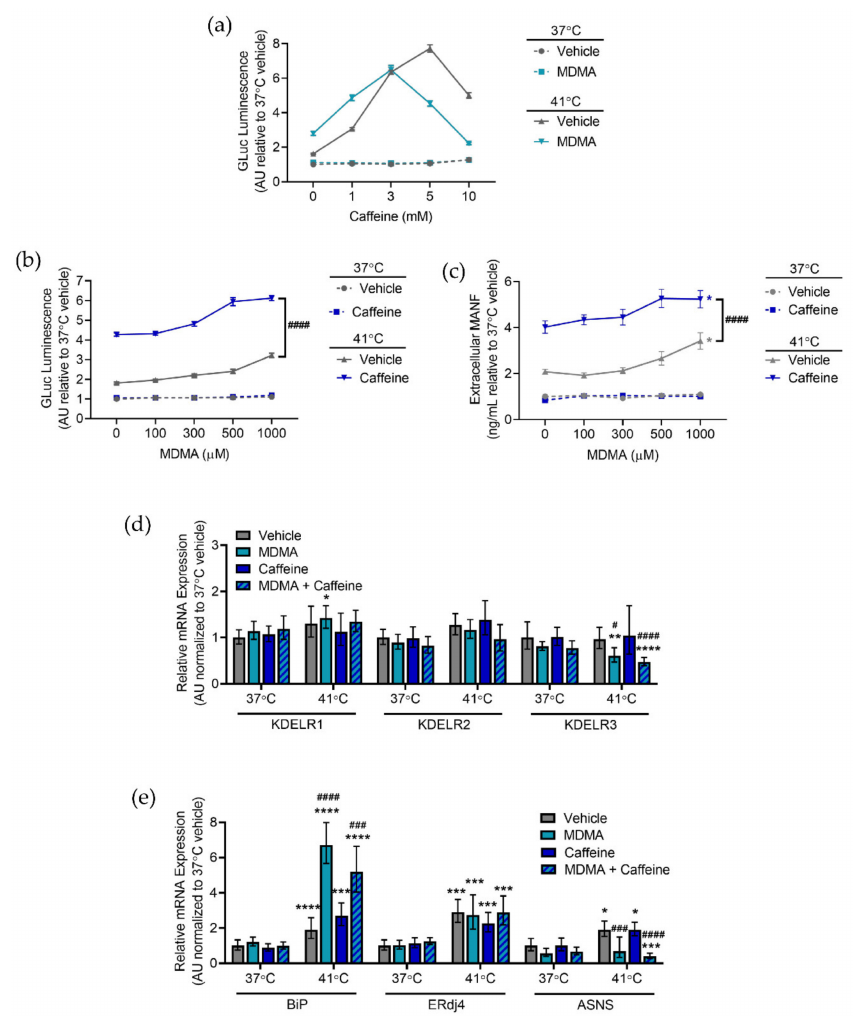
Figure 6. Caffeine and MDMA in combination affect hyperthermia-induced cellular responses. ( a ) GLuc (arbitrary units: AU) in the media from SH-SY5Y cells stably expressing GLuc-ASARTDL after treatment with vehicle or 500 µ M MDMA in combination with a dose response of caffeine and incubation at 37 ◦ C or 41 ◦ C for 24 h (mean ± SEM, n = 24). ( b ) GLuc (arbitrary units: AU) in the media from SH-SY5Y cells stably expressing GLuc-ASARTDL after treatment with vehicle or 1 mM caffeine in combination with a dose response of MDMA and incubation at 37 ◦ C or 41 ◦ C for 24 h (mean ± SEM, n = 24, three-way ANOVA with slice decomposition, #### p < 0.0001 vehicle vs. caffeine at 41 ◦ C). ( c ) MANF in media from SH-SY5Y cells treated with vehicle or 1 mM caffeine in combination with a dose response of MDMA and incubation at 37 ◦ C or 41 ◦ C for 24 h (mean ± SEM, n = 6, three-way ANOVA with slice decomposition, * p < 0.05 vehicle vs. MDMA at 41 ◦ C, #### p < 0.0001 vehicle vs. caffeine at 41 ◦ C. ( d ) KDELR1 , KDELR2 , and KDELR3 mRNA levels analyzed with real-time RT-qPCR after treatment with vehicle, 1 mM MDMA, 1 mM caffeine, or a combination of 1 mM MDMA and 1 mM caffeine and an 8 h exposure to 37 ◦ C or 41 ◦ C. Data are shown as relative mRNA expression (arbitrary units: AU) relative to control (2 − ddCq ± upper and lower limits, n = 8, two-way ANOVA with Sidak’s multiple comparisons, * p < 0.05, ** p < 0.01 and **** p < 0.0001 37 ◦ C vs. 41 ◦ C, # p < 0.05 and #### p < 0.001 vehicle vs. drug treatment). ( e ) BiP , ERdj4 , and ASNS mRNA levels analyzed